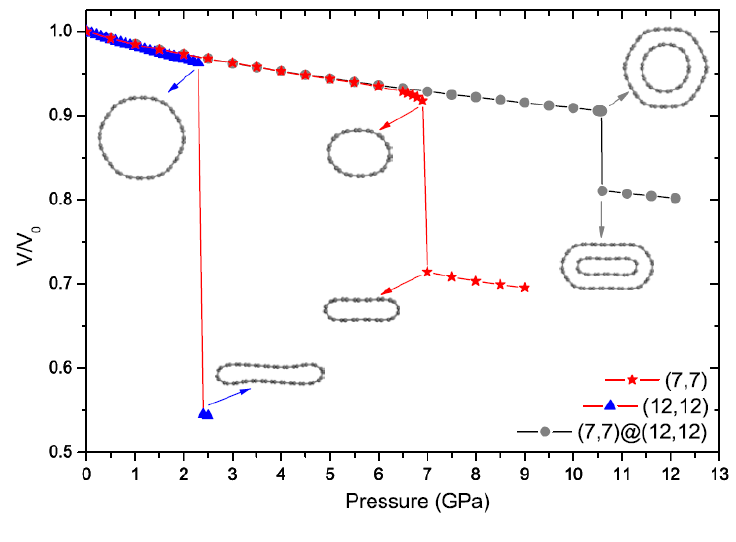
Figure 6. Change in the relative volume of the (7,7)@(12,12) DWNT bundle and the corresponding SWNT bundles as a function of hydrostatic pressure. Reprinted from Reference